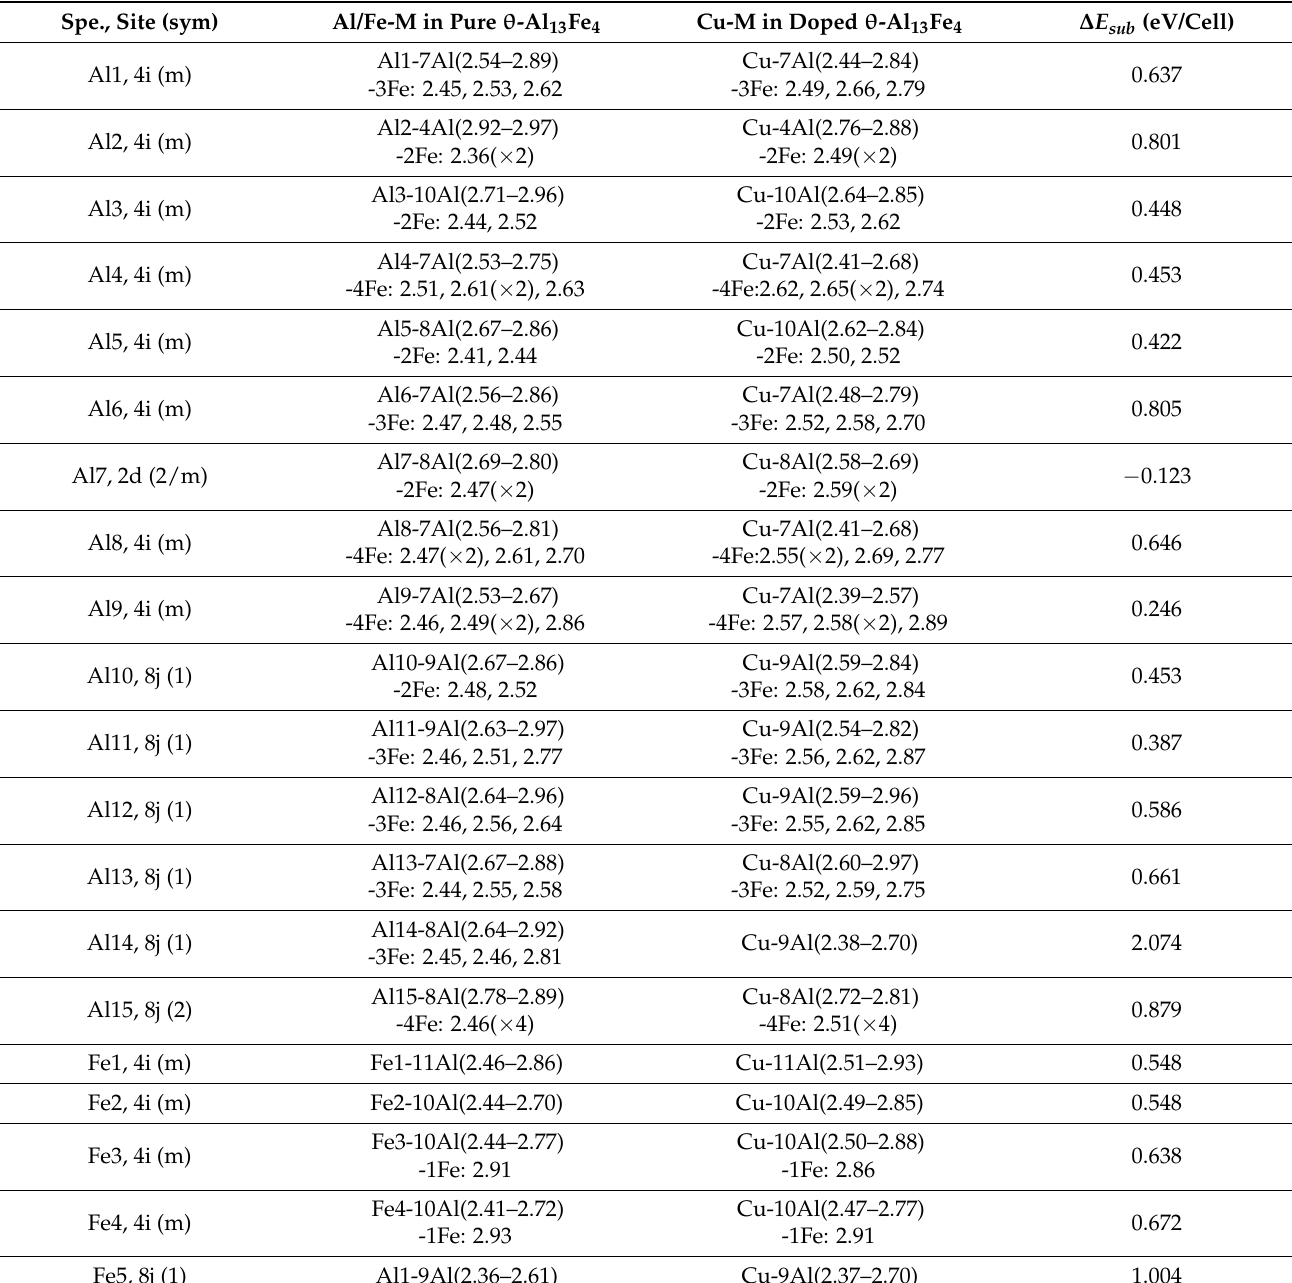
Table 3. Results (local coordination and substitution energy according to Equations (3) and (4)) for one Cu substitution at the Al and Fe sites in θ -Al 13 Fe 4 from the GGA + U (U = 4 eV for Cu 3d) approach. Coordination of the related Cu-M (M = Al or Fe) with 3.0 Å in the substituted structures and Al/Fe-M in pure θ -Al 13 Fe 4 is